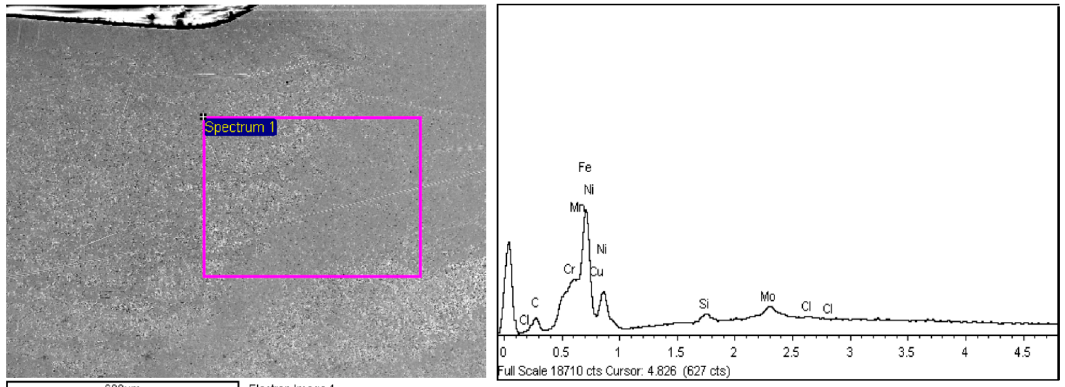
Figure 6. SEM spectrum and micrograph of the AISI 304 steel weld with AISI 316L filler welded in a conventional atmosphere and irradiated at 200 Gy.